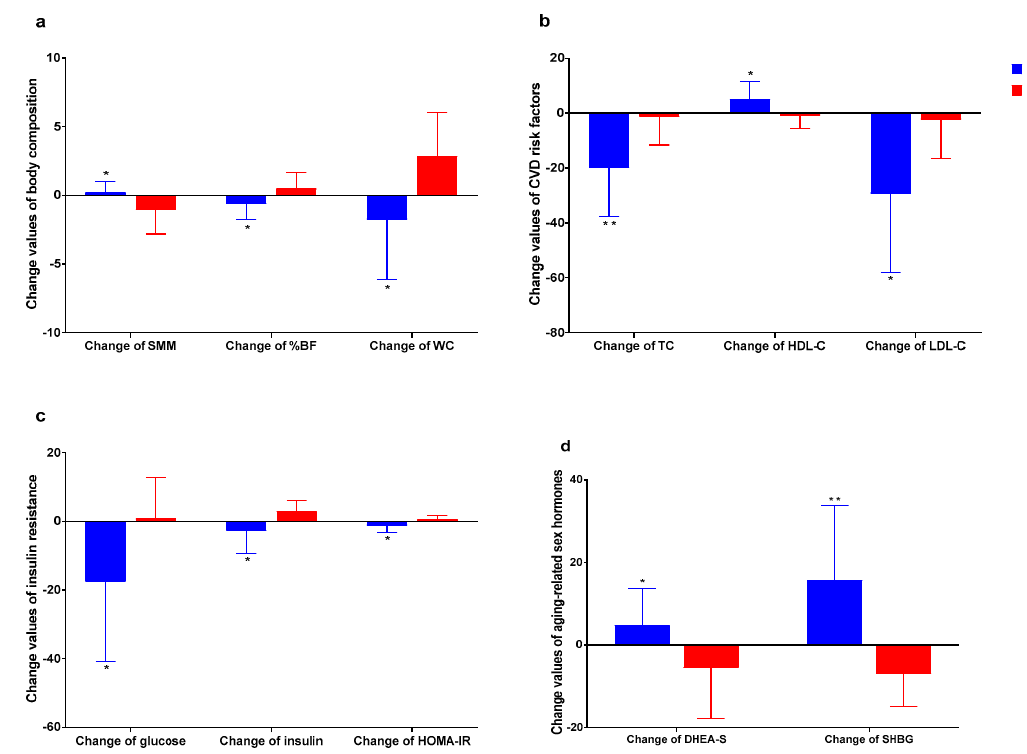
Figure 6. Difference in the change value of each of the variables. ( a ) Body composition; ( b ) Cardiovascular disease risk factors; ( c ) Insulin resistance. ( d ): Aging-related sex hormones. * p < 0.05, ** p < 0.01.